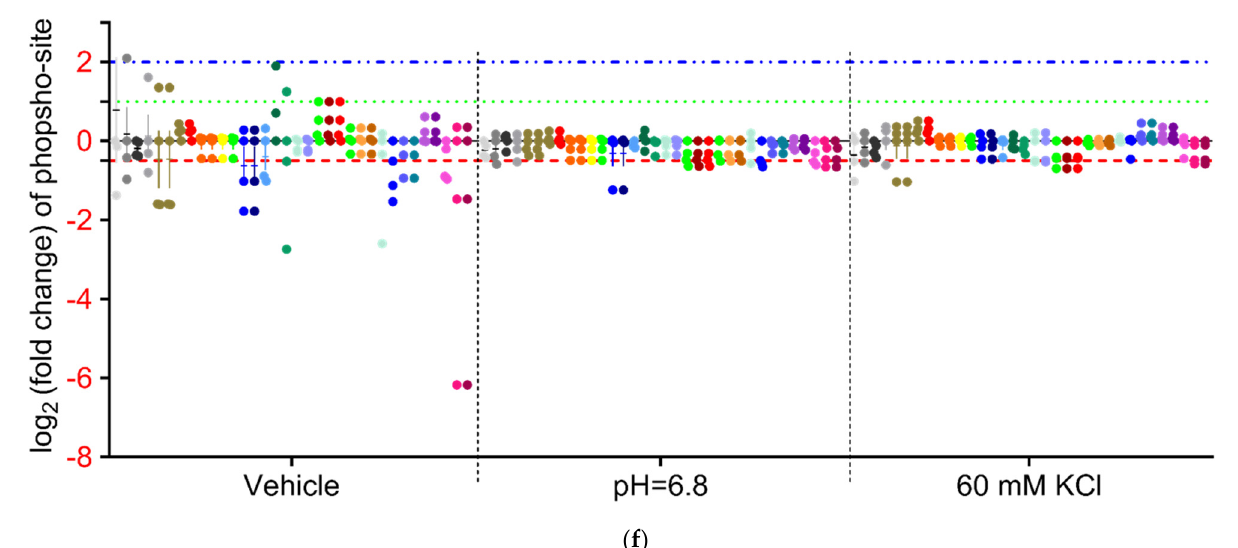
Figure 8. Scatterplots of significantly enriched phosphorylated proteins against physiologically associated proteins significantly enriched in phosphorylation following ( a ) vehicle, ( c ) acidified pH, and ( e ) 60 mM KCl insult. Individual fold change plots of phosphorylation-site enrichment, separated by ( b ) vehicle-enriched, ( d ) acidified pH-enriched, and ( f ) 60 mM KCl-enriched phosphorylation; individual dots on these plots correspond to listed verified detected PTM sites. When separated by treatment group, unique patterns of phosphorylation of ZO-1 can be identified by individual treatment, indicating PTM-regulated protein trafficking converges on this protein. Italicized proteins in scatterplots lacking verifiable phosphorylation sites were not included in individual fold change plots. Individual phosphorylated residues are colored red and superscript indicates position of phosphorylated amino acid; residue sequences marked with an asterisk indicate isobaric phosphorylation sites and were graphed as individual iterations of phosphopeptide enrichment. ( g ) Venn diagram illustrating overlap of phosphorylation adduct sites on ZO-1 residues by treatment group.